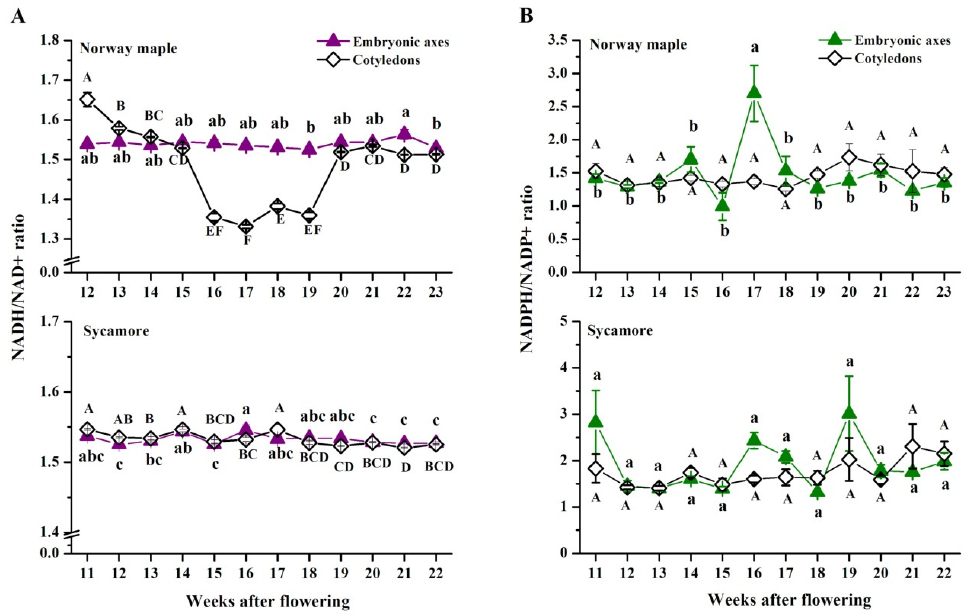
Figure 9. Changes in the ratios of ( A ) reduced (NADH) to oxidized (NAD + ) forms of nicotinamide adenine dinucleotide (NAD) and ( B ) reduced (NADPH) to oxidized (NADP + ) forms of nicotinamide adenine dinucleotide phosphate (NADP) in the embryonic axes and cotyledons of the developing seeds of Norway maple and sycamore collected during the 11th–23rd weeks after flowering. Data are the means of three independent replicates ± the standard error. Statistically significant differences are indicated with different letters (one-way ANOVA, followed by Tukey’s test at p < 0.05). The capital letters refer to the embryonic axes.